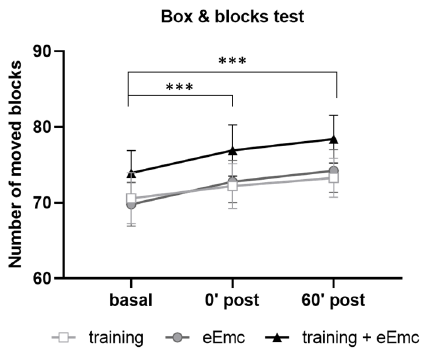
Figure 3. Number of moved blocks in the box and blocks test (BBT) for hand training, eEmc, or combination of both interventions right after intervention (0′ post) and during follow-up (60′ post) in comparison to basal evaluation. Significant differences between timepoints according to Tukey’s multiple comparisons (considering all intervention groups as a whole): *** p < 0.001.